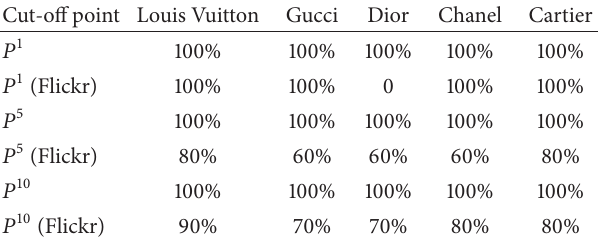
Table 4: The comparison of the cut-off point precision between the proposed method and Flickr. Cut-off point Louis Vuitton